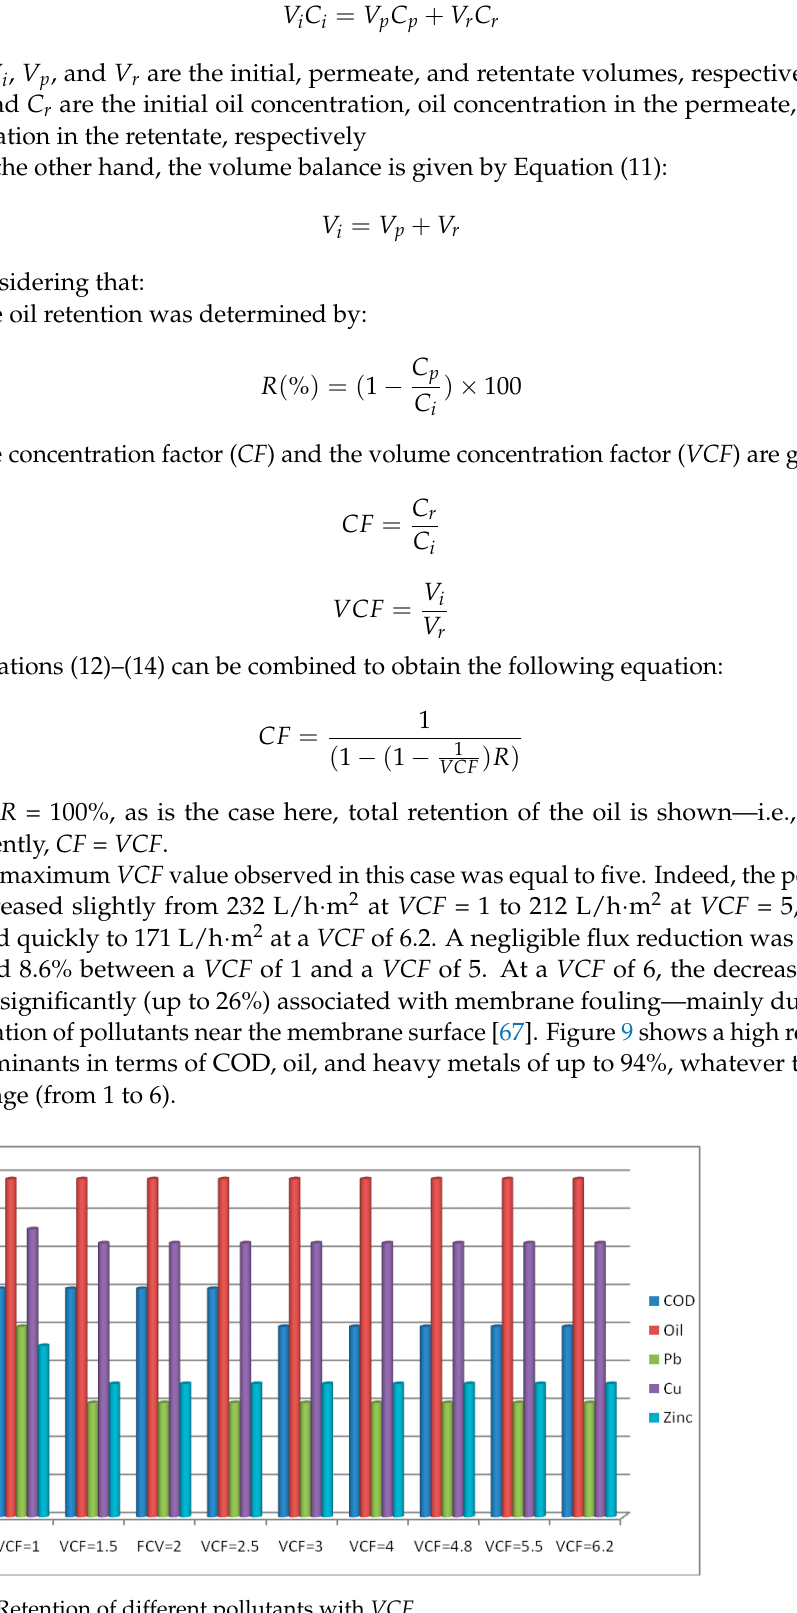
Figure 9. Retention of different pollutants with VCF